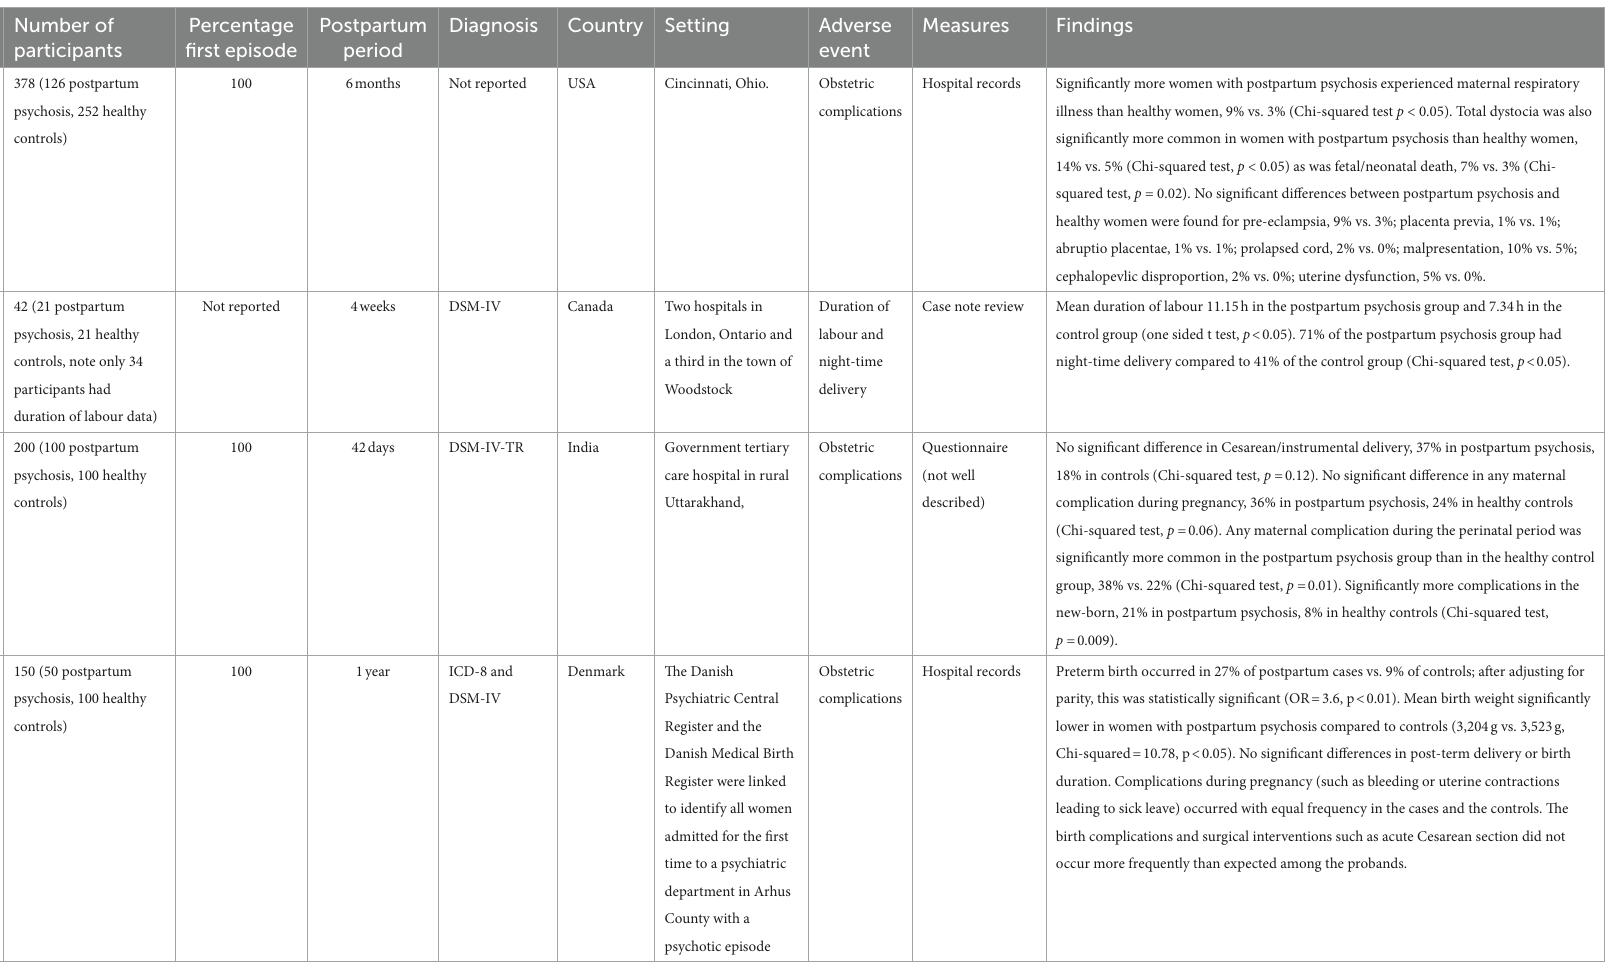
DSM, Diagnostic and Statistical Manual; SCID, Structured Clinical Interview for DSM; LTE, List of Threatening Experiences; SD, Standard Deviation, International Classification of